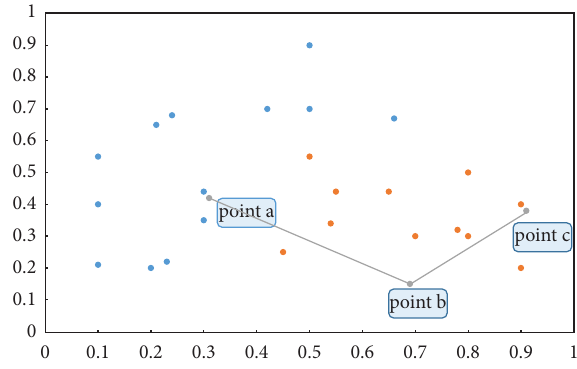
Figure 4: Euclidean distance can roughly refect the global con- sistency of cold chain logistics